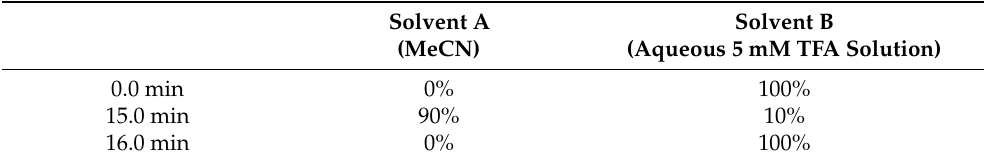
Table 9. Applied gradient flow of analytical HPLC (column: Luna C18(2) 150 mm × 4.6 mm, 100 Å, 3 µ